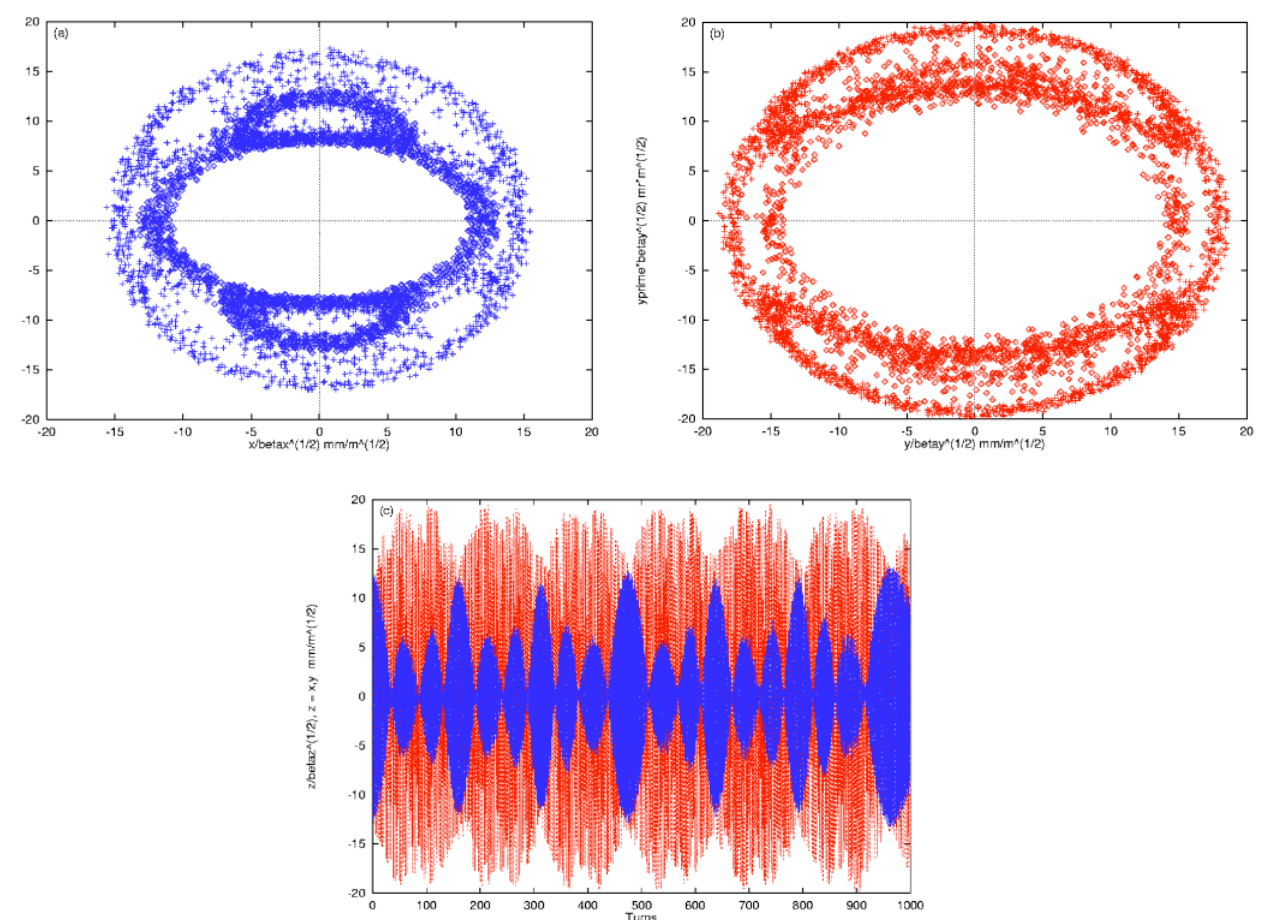
FIG. 13. (Color) Coupled x - y motion in PCM: (a) horizontal and (b) vertical Poincaré plots of single particle motion, and (c) horizontal (blue) and vertical (red) position plots of particle versus turn number. The effects of x - y coupling are prominent in the latter